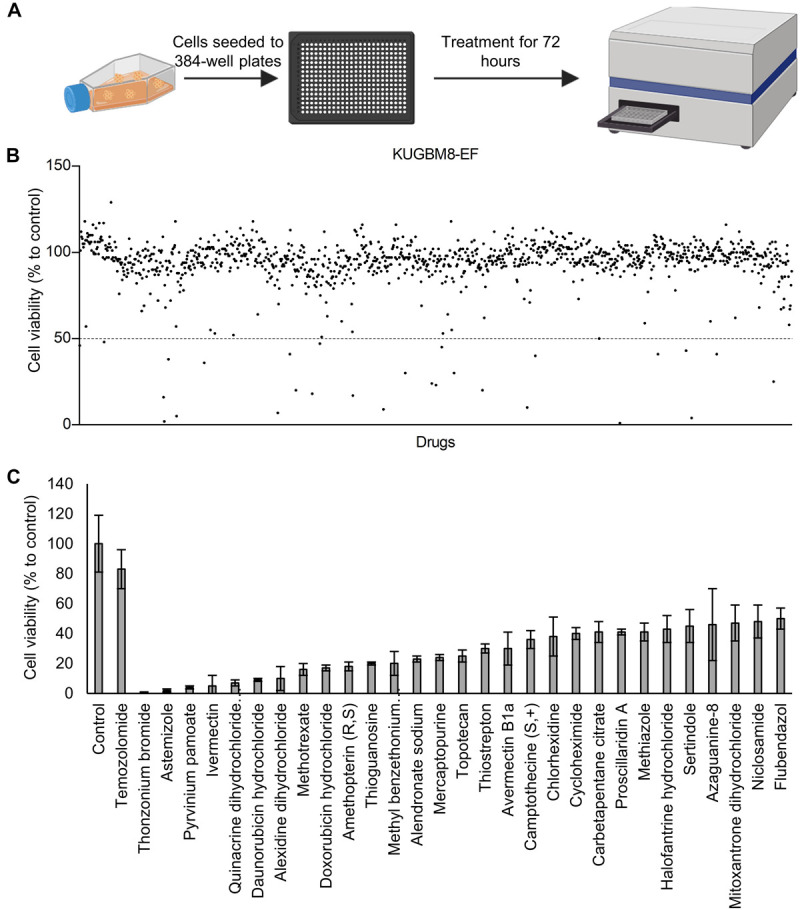
Drug repurposing screen performed on KUGBM8-EF cells. (A) Schematics of the screen. (B) Cell viability results detected by Cell Titer Glo (CTG) after 72 h of treatment. Drug treated cells were normalized to untreated wells. N = 4 for each condition. (C) Hits determined by 50% cell viability threshold. Error bars represent Normalized Standard Deviation. All hits have a significant p-value (p < 0.05) compared to control group, t-test.